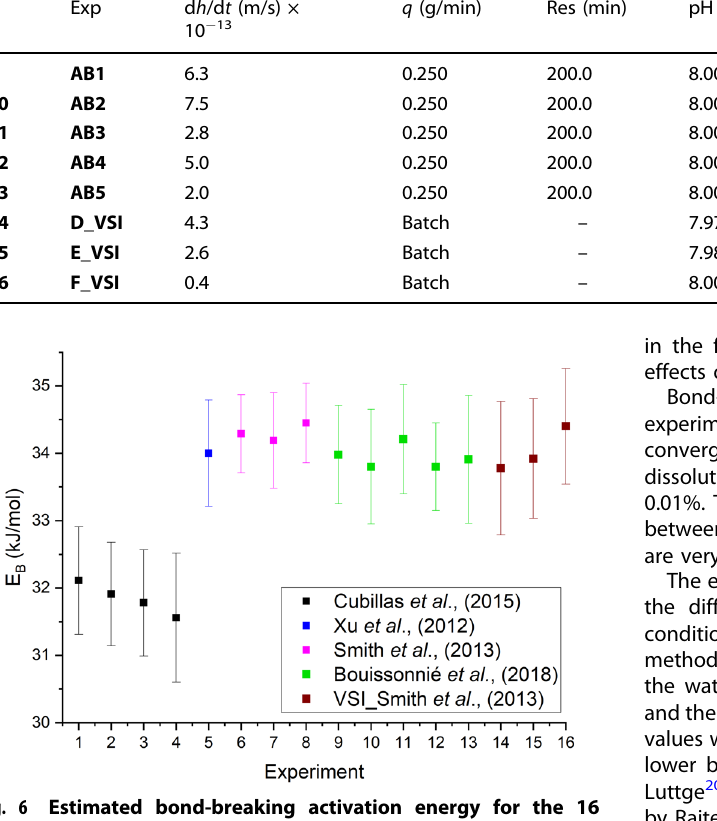
Table 6. Experimental conditions with dh/dt the retreat velocity, q the fl ow rate and Res the residence time of the solution in the reactor. N